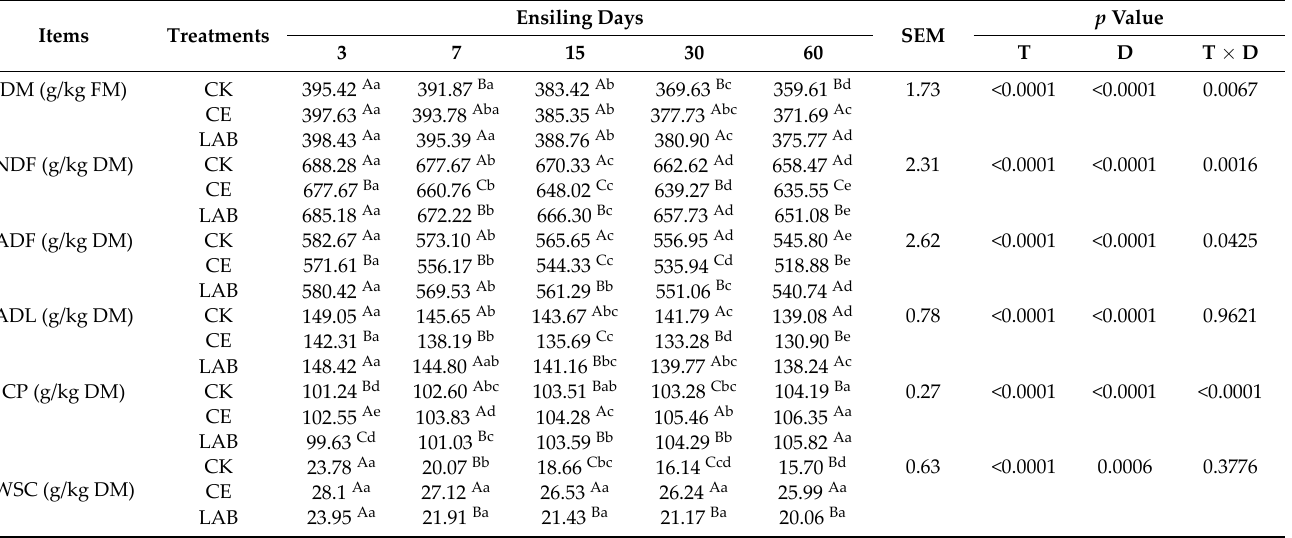
Table 3. Effects of additives and ensiling days on chemical composition of Caragana korshinskii